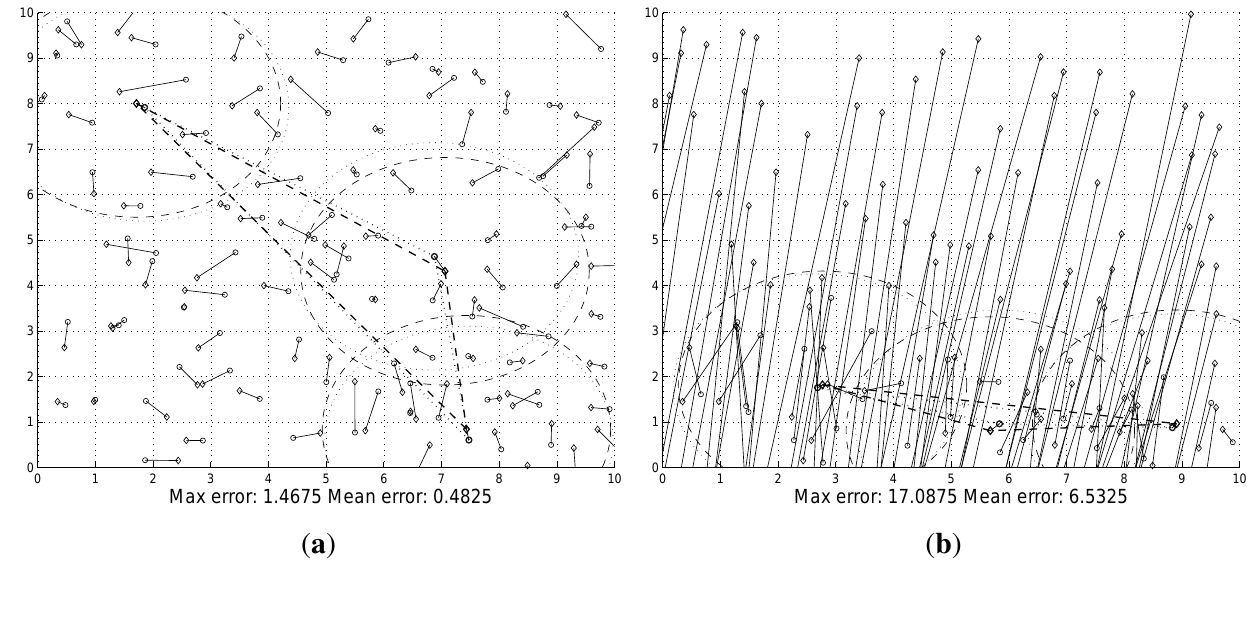
Figure 1. Sample localization results. ( a ) reasonable; ( b )